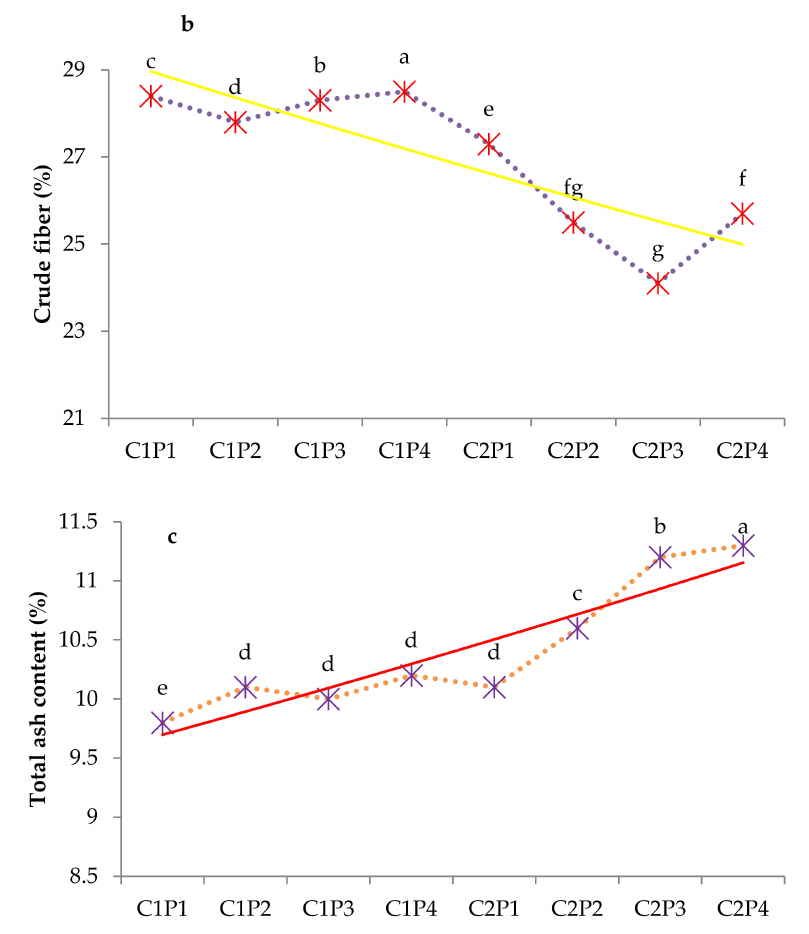
Figure 4. Nutritive quality: ( a ) protein content, ( b ) crude fiber content and ( c ) total ash content of forage cowpea cultivars sown under varying row configurations (details of treatments are presented in the footnote of Tables 1 and 2). Different letters show significant difference at p =